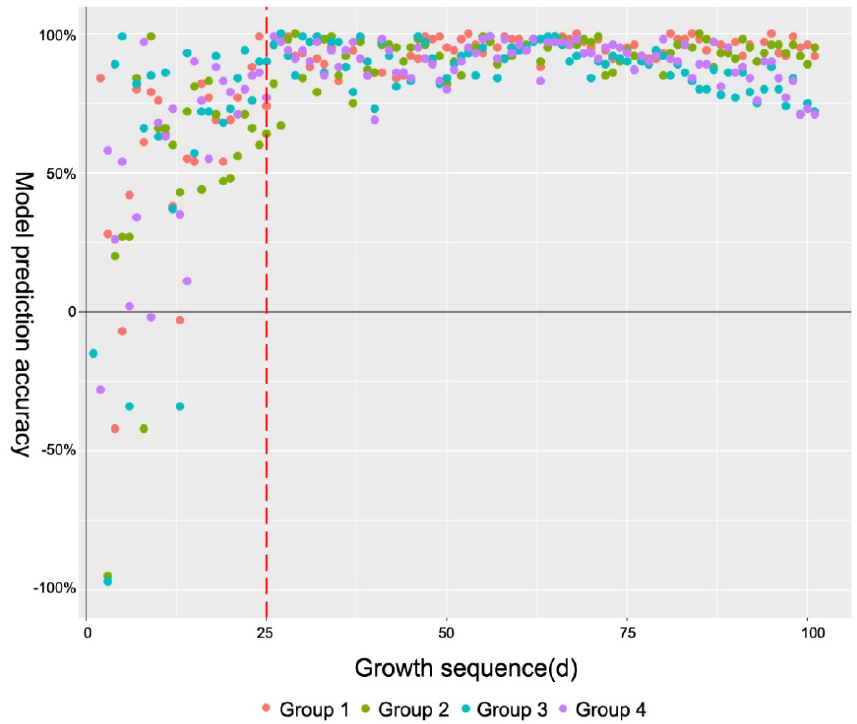
Figure 9. Scatter plot of inversion accuracy of Y27 for the samples of four groups. The figure shows only the inversion accuracy values in the interval [ − 1, 1]. The red dotted line in the figure caption is only the inversion accuracy values in the interval [ − 1, 1]. The red do tt ed line in the fi gure caption is the auxiliary observation line at the 25 th day of growth sequence. the auxiliary observation line at the 25th day of growth